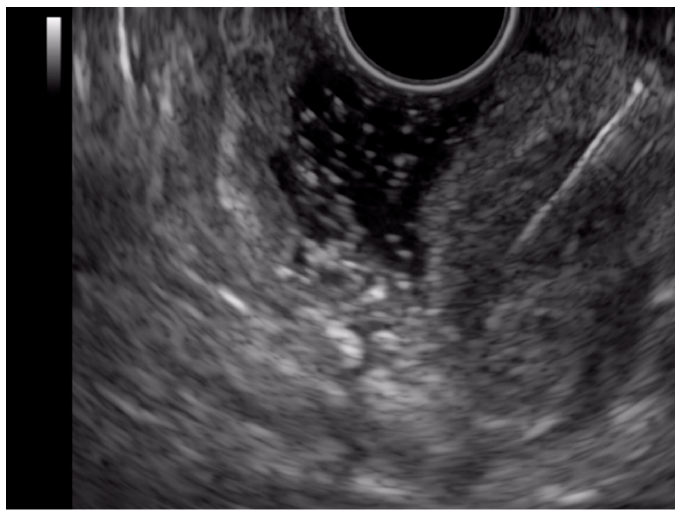
Figure 5. EUS jejunal tumor with FNA biopsy.